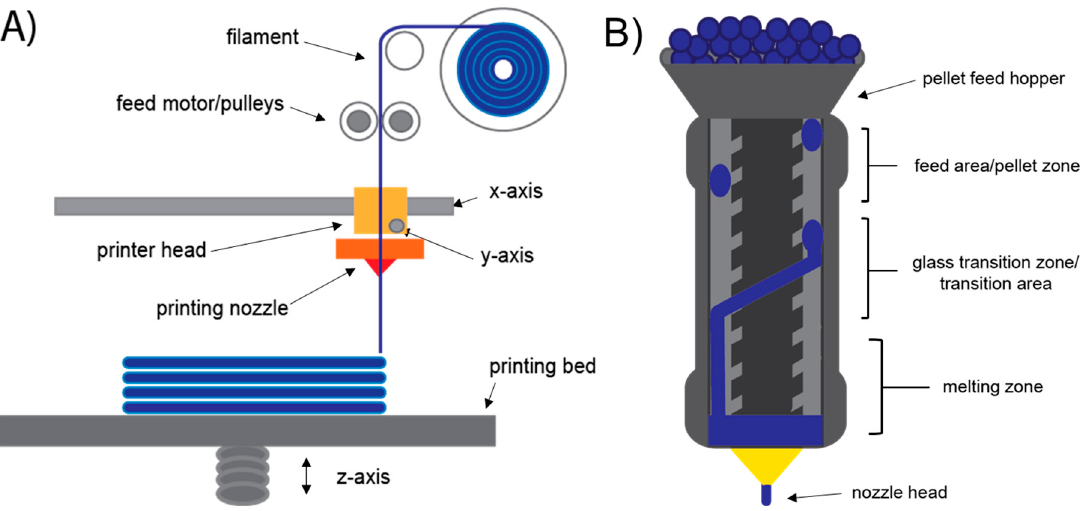
Figure 1. ( A ) Process of fused filament fabrication (FFF) 3D printing. ( B ) Single-screw extrusion printer head on a pellet-fed materials extrusion system.